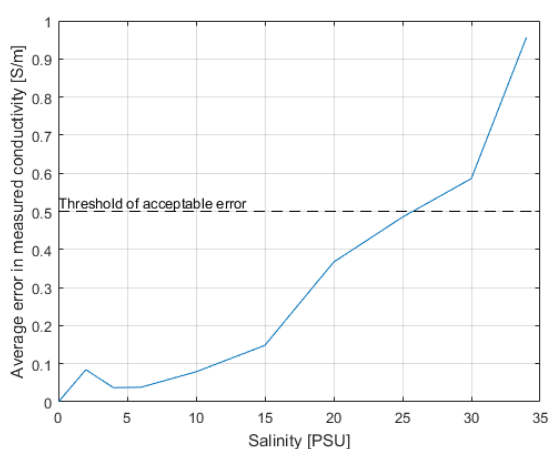
Figure 11. The distribution of mean absolute error for all probes for different salinity